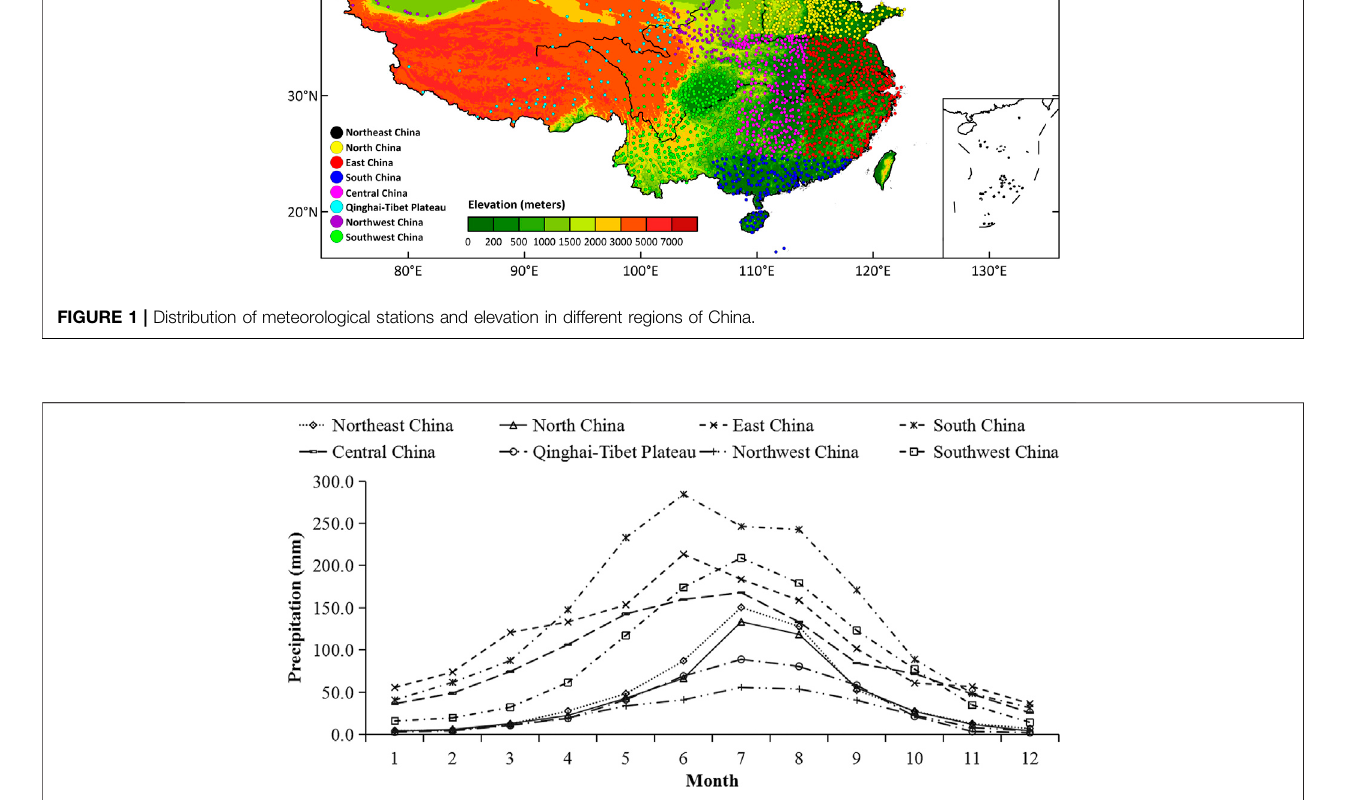
FIGURE 2 | Climatological monthly precipitation of each region in